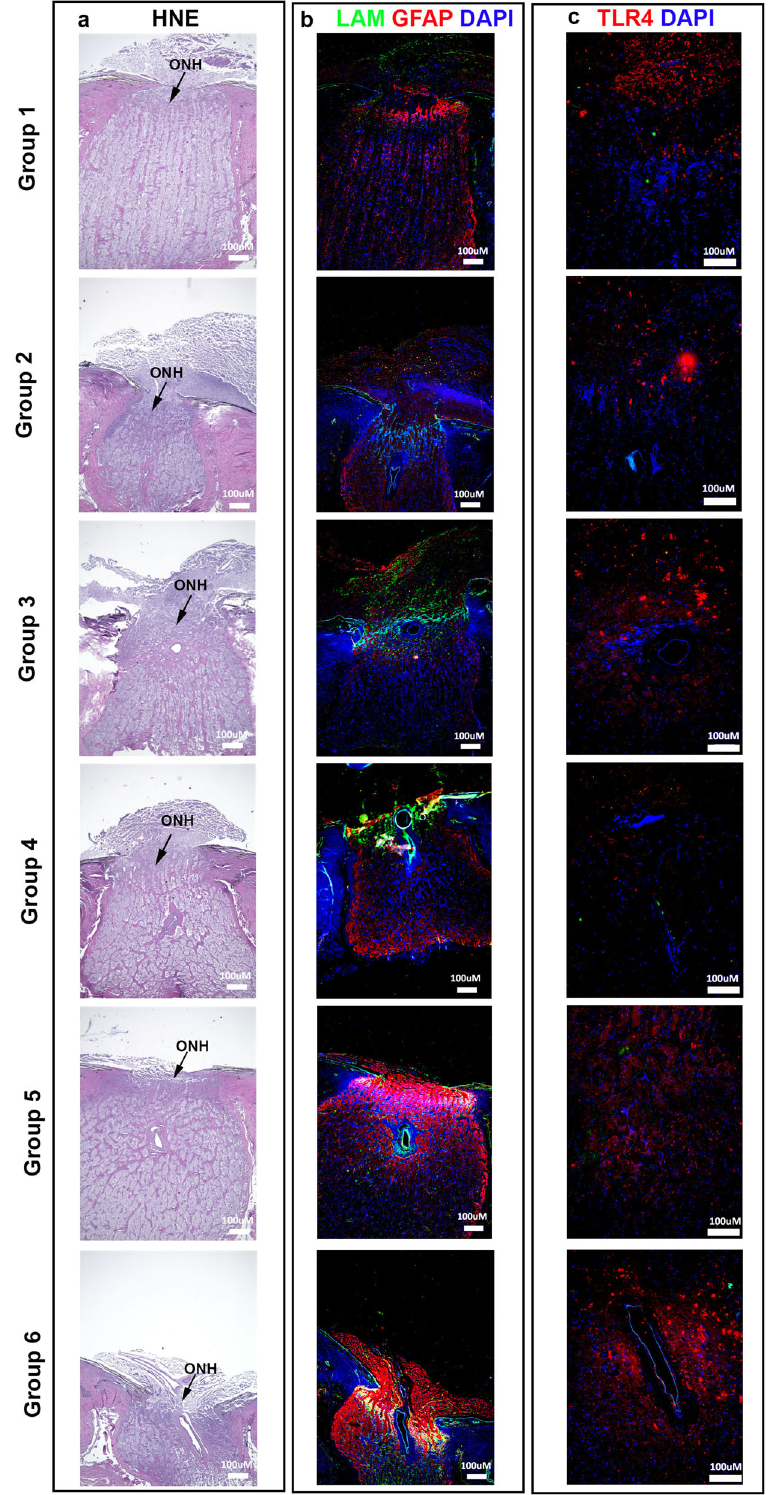
Fig. 6 Morphological restructuring of the optic nerve head after perfusion culture. Cross sections of human ONH depict ( a ) H&E staining of Group 1, Group 2, Group 3, Group 4, Group 5 and Group 6. Expression of ( b ) LAM, GFAP with DAPI in the ONH of all 6 groups. Expression of ( c ) TLR4 with DAPI in the ONH of all 6 groups. LAM = green; GFAP, TLR4 = red; DAPI = blue; a , b 40x magni fi cation; c 100x magni fi cation. H&E hematoxylin and eosin stain, ONH optic nerve